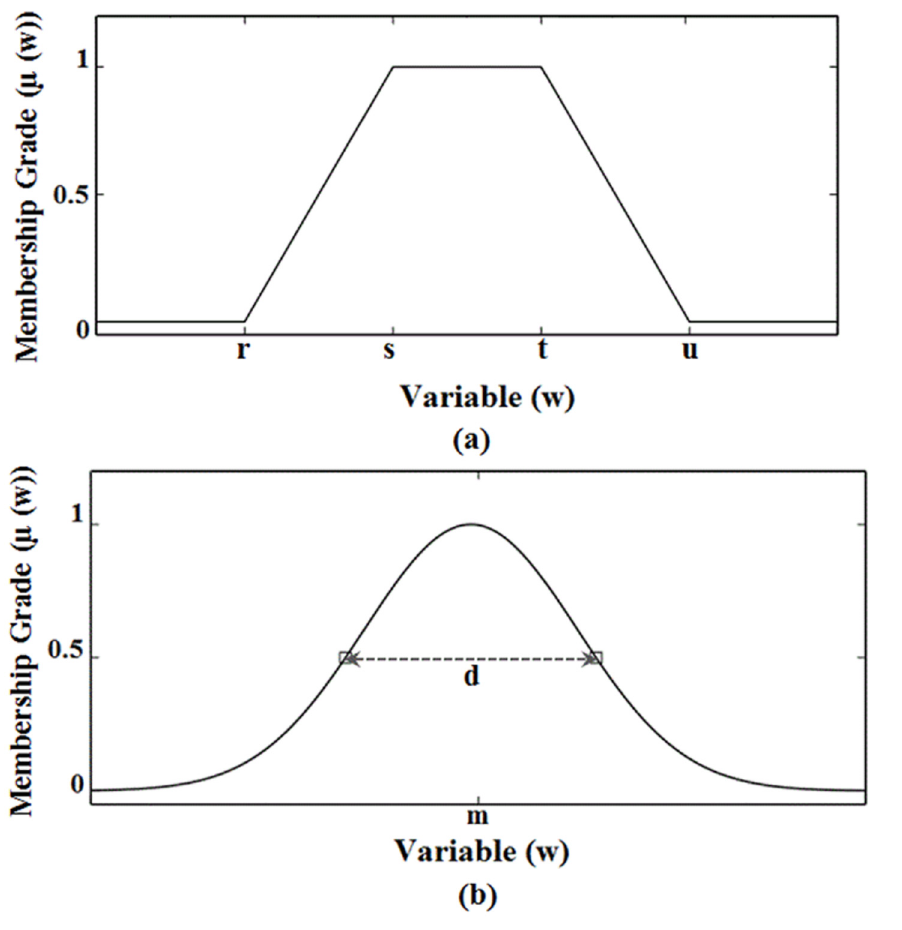
Fig 4. MF plots (a) Trapezoidal, (b)